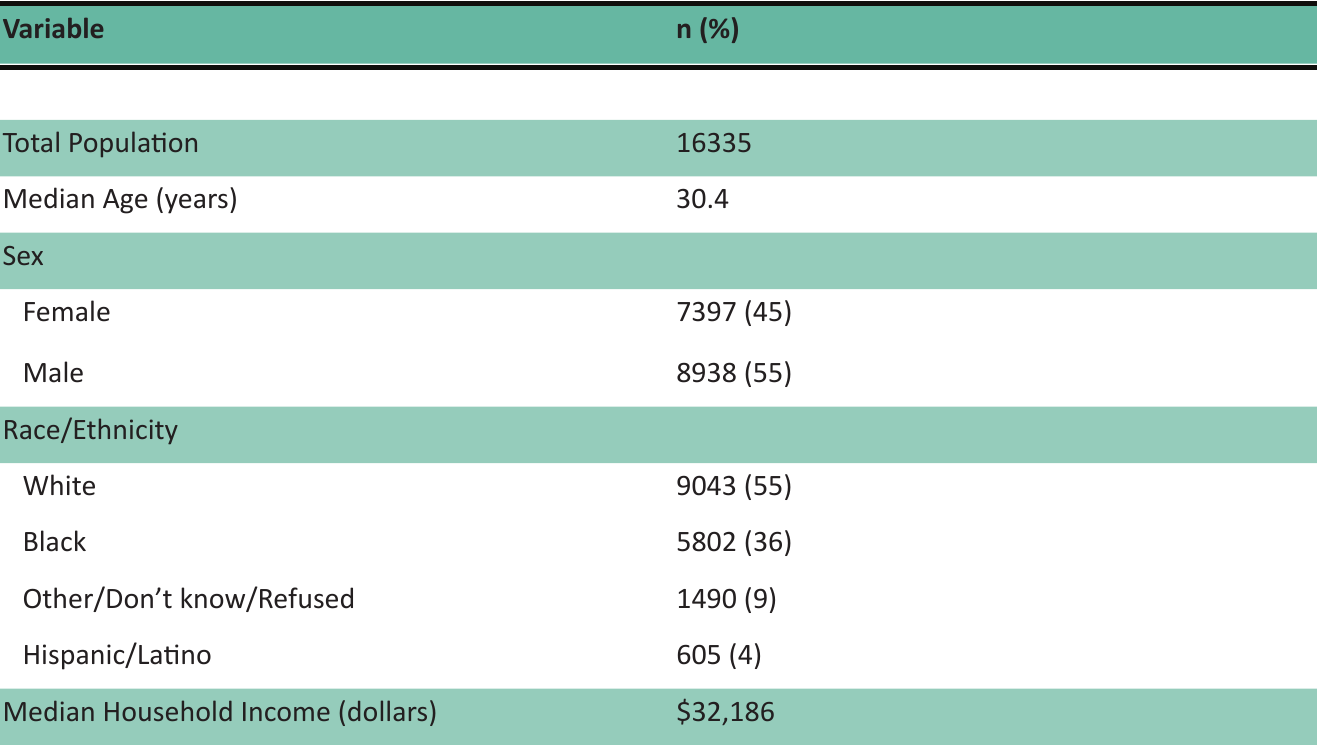
Table 4: Demographics of the Population in the 46202 Zip Code